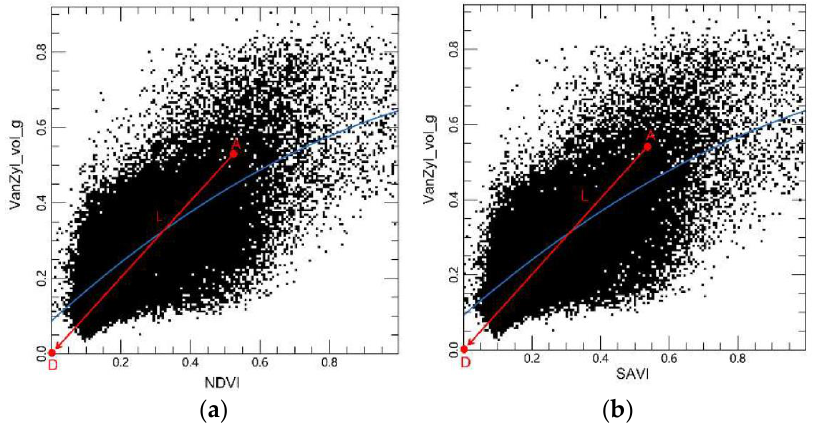
Figure 10. Construction of the vegetation-radar models: ( a ) NDVI-VanZyl_vol_g feature space; ( b ) SAVI-VanZyl_vol_g feature space. (The blue line is the trend line between the components; the red line L is the distance from any point A in the feature space to D (0,0)).